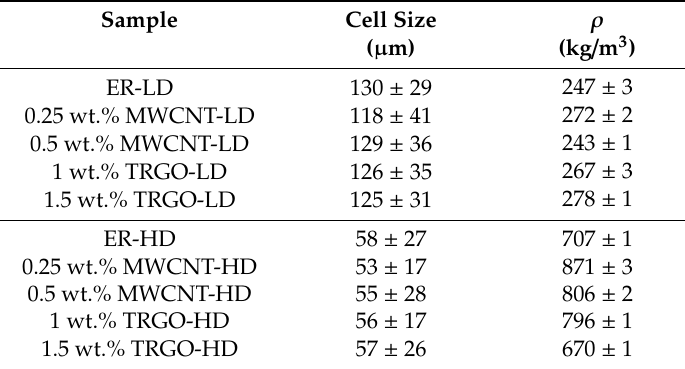
Figure 4. Cell size distribution of the foams. Table 2. Cell size and densities of the epoxy